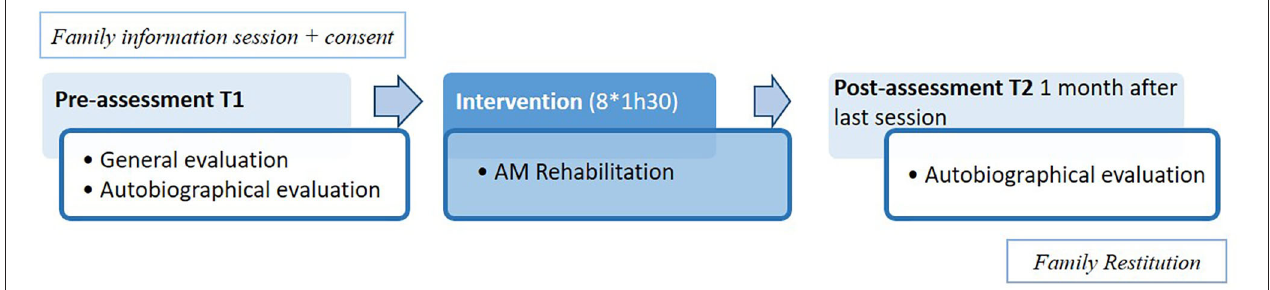
FIGURE 2 | General procedure of the SIAM rehabilitation program.